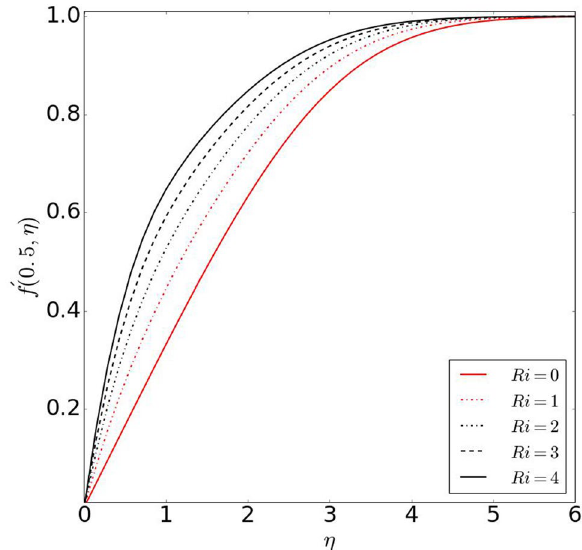
Fig. 14 Velocity Profile with different R i with fixed 𝜉 = 0.5 and 𝜙 = 0.05 for Al 2 O 3 -water nanofluids